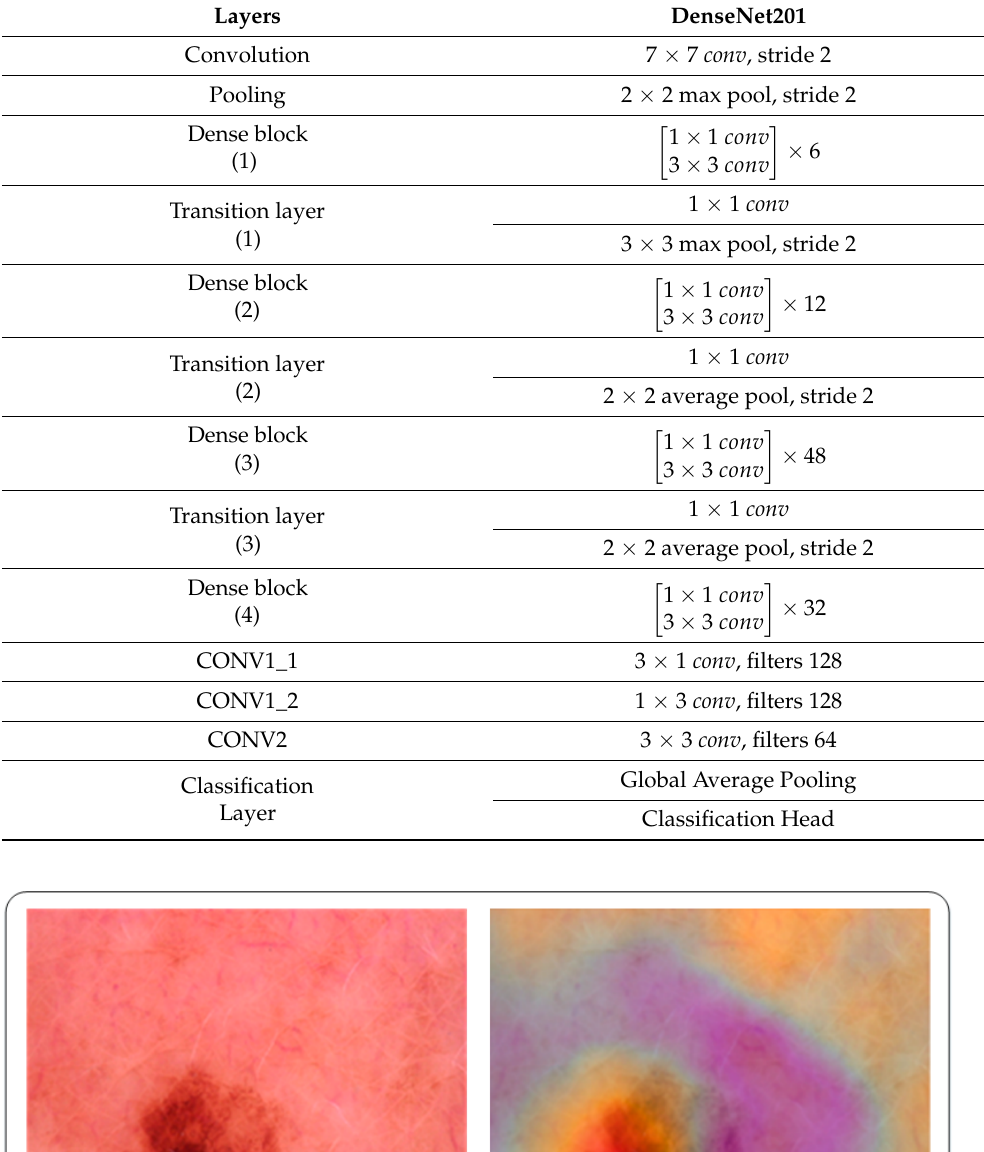
Table 2. Architecture of the proposed Modified DenseNet201.